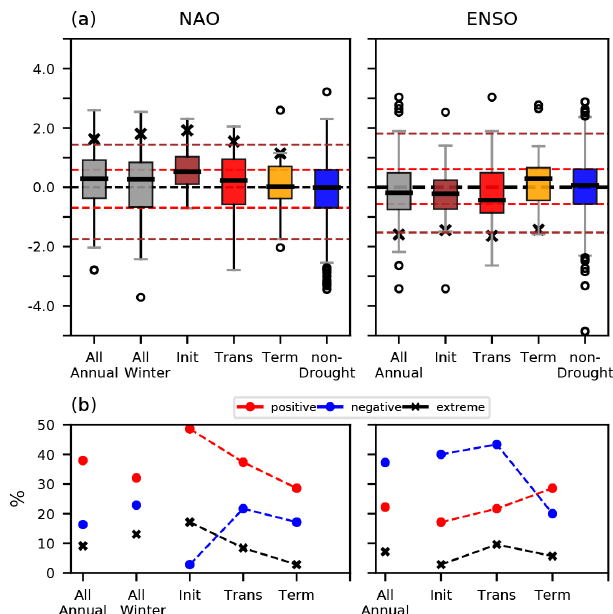
Figure 10. (a) Box plots of NAO and ENSO during multi-year Mediterranean droughts. Dashed red lines indicate the 25th and 75th percentiles of distributions of NAO and ENSO during non-drought periods that are taken as thresholds to discern relative negative or positive phases of NAO and ENSO. Dashed brown lines indicate the 5th and 95th percentiles of distributions that are taken as thresh- olds for extreme negative or positive NAO and ENSO. Black crosses represent the means of extreme positive NAO (values above the 95th percentile), and the means of extreme negative ENSO (values below the 5th percentile). (b) Frequencies of occurrence of positive and negative phases of NAO (left) and ENSO (right) in annual, winter, and each stage of droughts. Black crosses indicate the frequencies of occurrence of extreme positive NAO and extreme negative